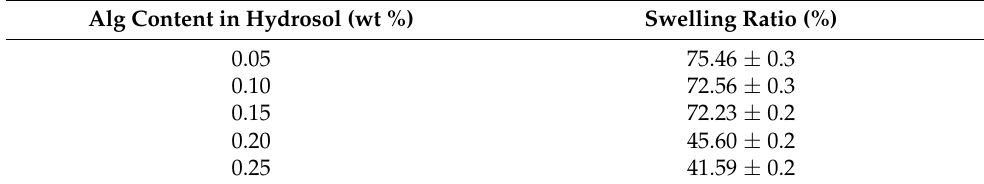
Table 2. Swelling ratios of Alg/HA/ICol